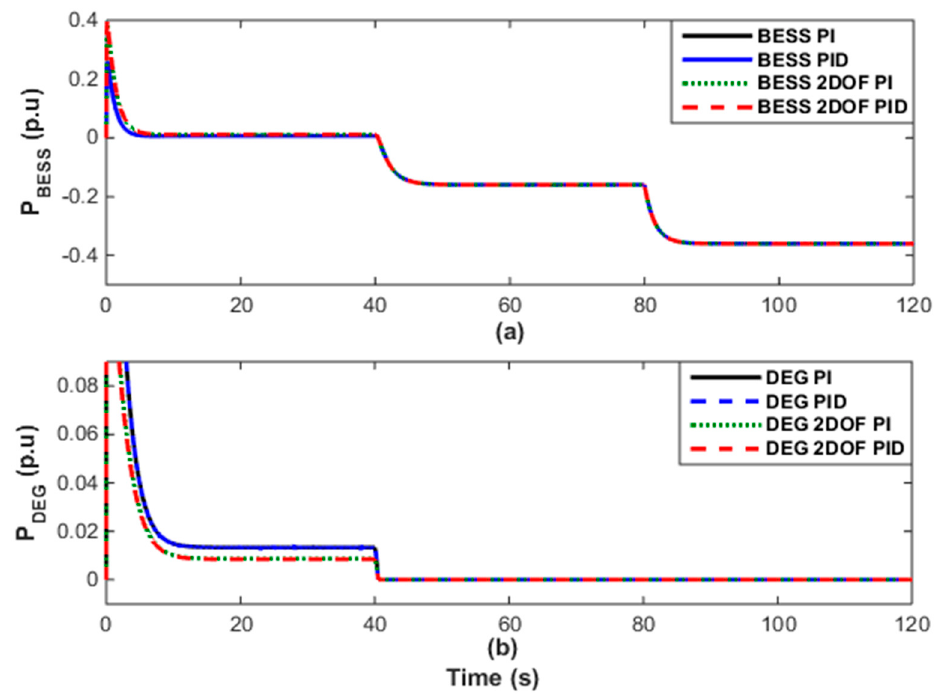
Figure 4. Power-sharing of the ( a ) BESS and ( b ) DEG in case 1.